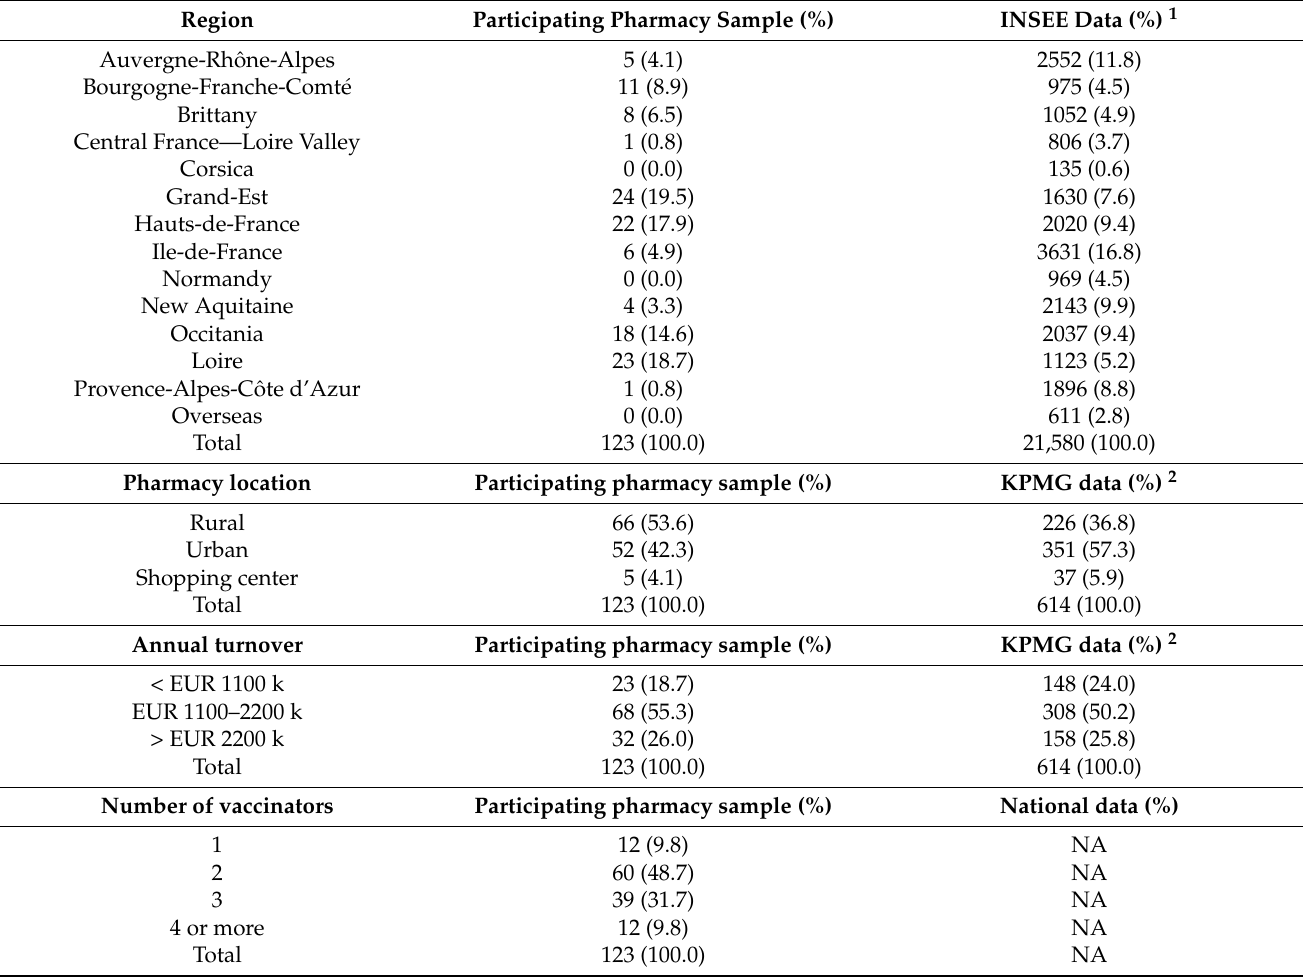
Table 1. Characteristics of community pharmacies participating in the study.